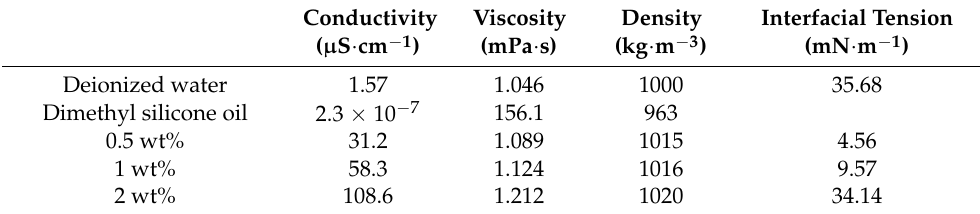
Figure 3. Infrared spectrogram of NPs [43].